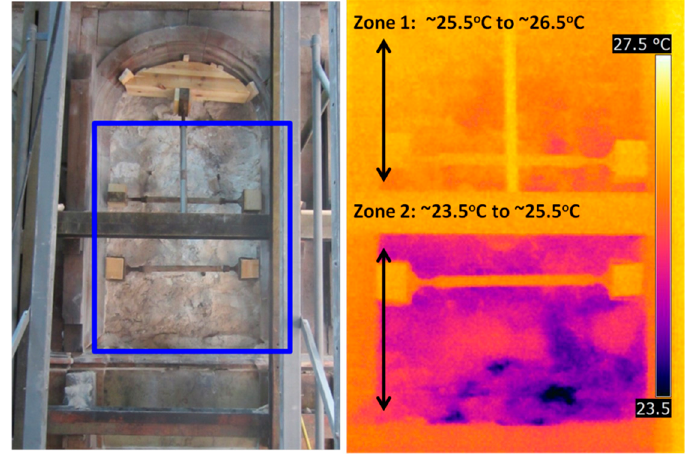
Figure 36. N2 panel with the filling mortar layer and corresponding IRT image.